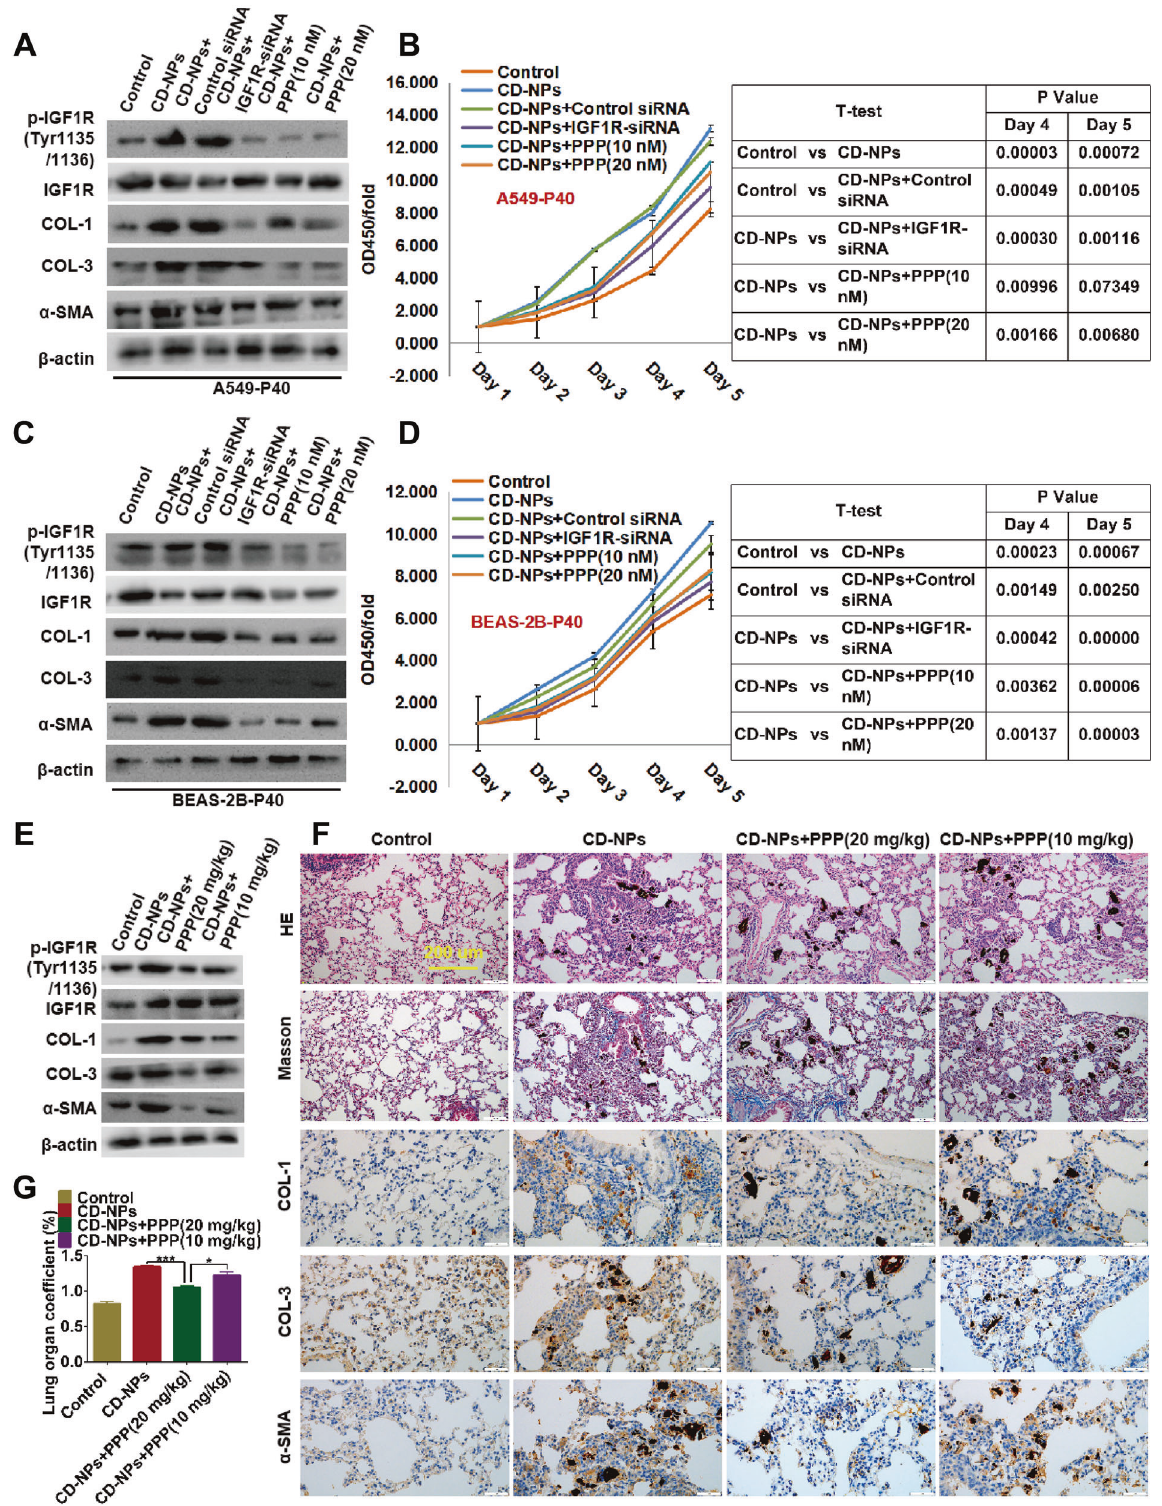
Fig. 3 Activation of IGF1/IGF1R signaling positively regulates CD-NPs-induced PF. A , C After inhibition of IGF1R in an in vitro models of pre- fi brosis, IGF1/IGF1R signaling was detected by western blot. B , D After inhibition of IGF1R in an in vitro models of pre- fi brosis, cell viability was examined by CCK-8 assay. E , F IGF1/IGF1R signaling was detected by western blot and immunohistochemistry in an in vivo models of pre- fi brosis. G Lung coef fi cients in an in vivo pre- fi brotic model. Data were expressed as the mean ± SD, n = 3. * P < 0.05 and *** P < 0.001.